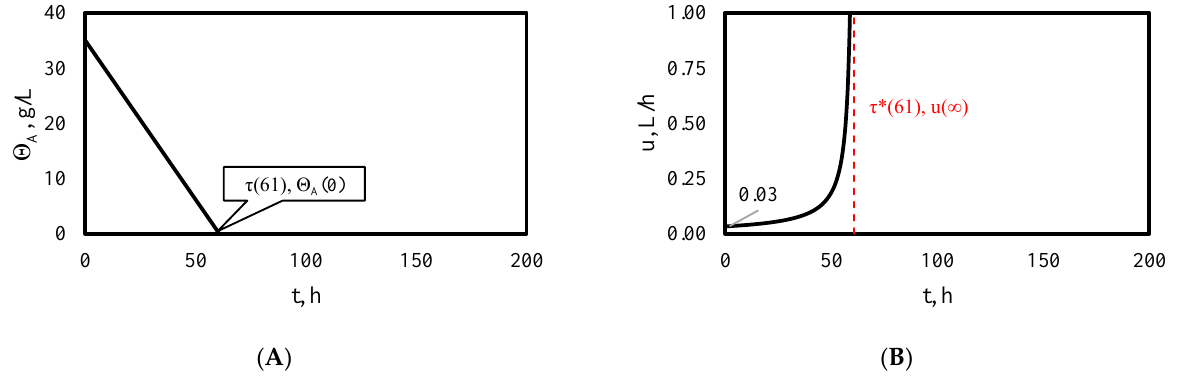
Figure 5. Route of the state of lubrication system with a regulator for 2 L of lubricant in oil pan. ( A ) Profile of the difference in partial densities of lubricant precursors between the crankcase and the engine and ( B ) Optimal route of lubricant supply to the interior of the engine.